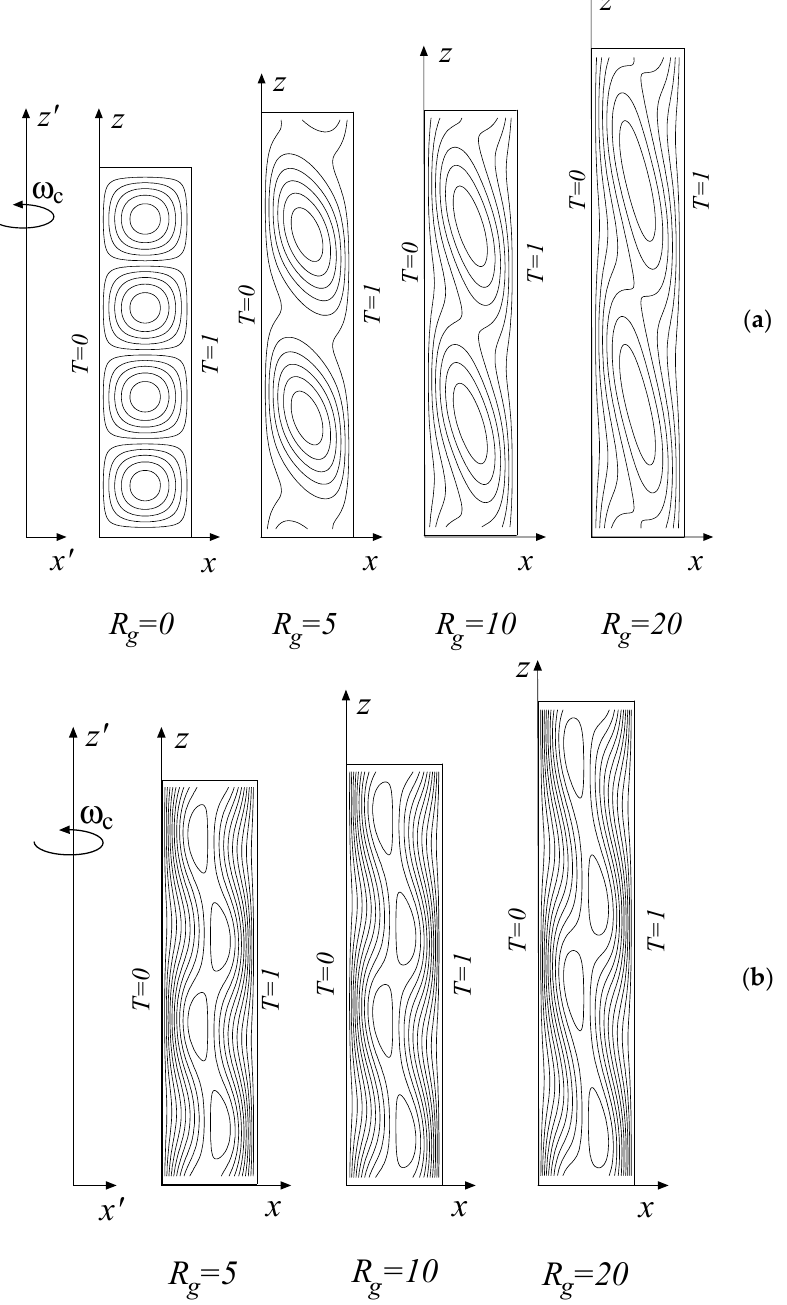
Figure 16. The convective flow field (streamlines) at marginal stability for different values of R g ( = Ra g / π ); ( a ) the odd modes; ( b ) the even modes. (Reproduced with permission from Hindawi [43].)